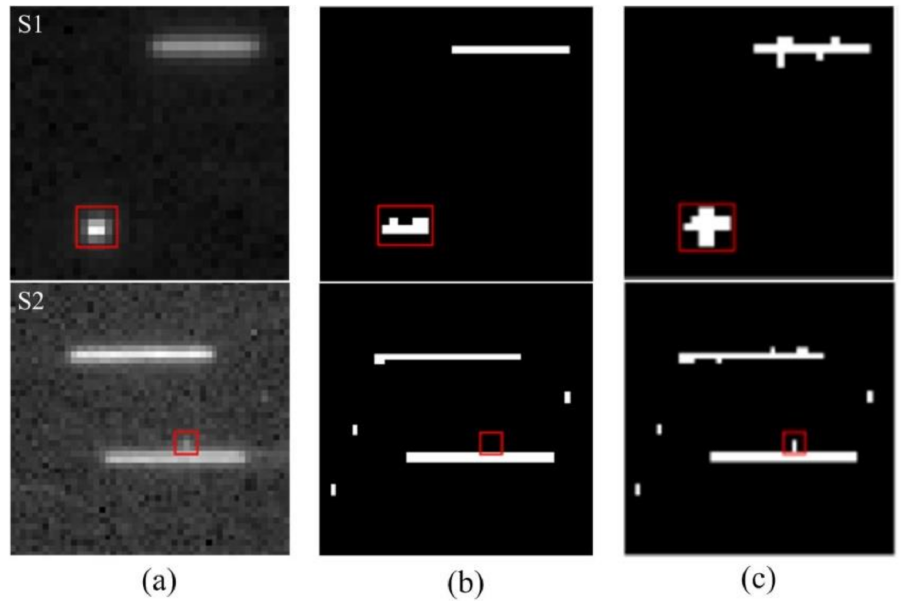
Figure 6. Recognition results in two scenes including point objects and star streaks are shown, and the difference between the two scenes is whether the point object in the image is close to the streak. Supplementary recognition is beneficial to the completion of point object contour recognition, but has little effect on streak recognition. ( a ) Original images containing stars and objects. ( b ) Column recognition. ( c ) Horizontal supplementary